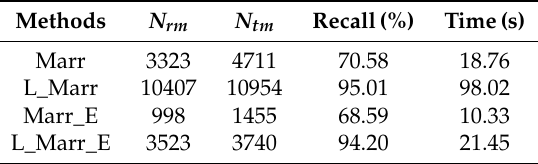
Table 3. Experimental comparison results for quantitative analysis of feature point matching.